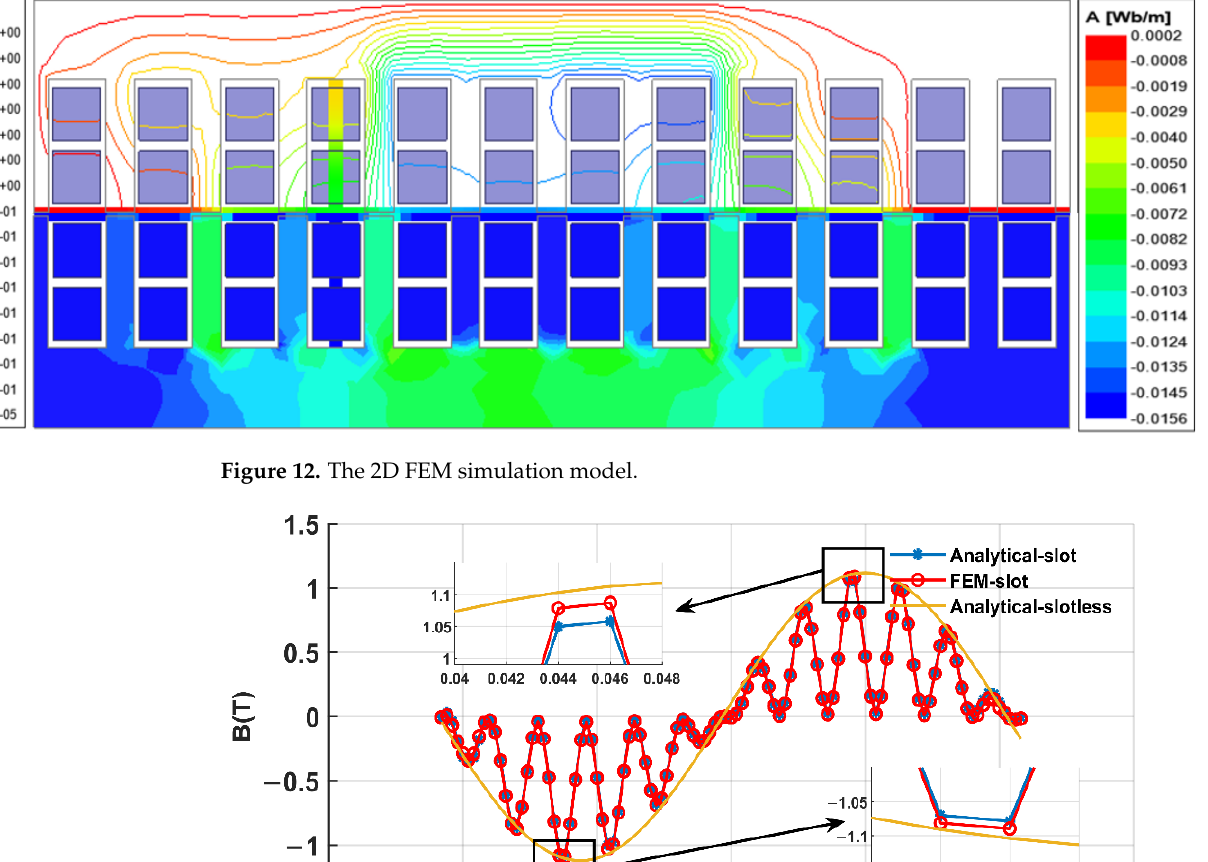
Figure 13. The air-gap flux density distribution of the UP-LPST.